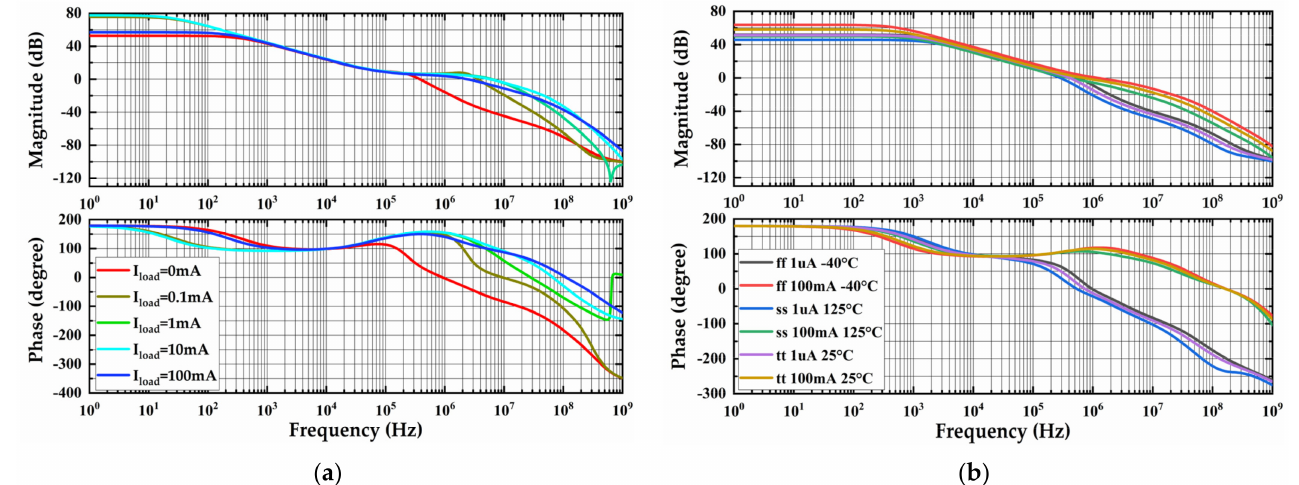
Figure 8. ( a ) Loop gain of the proposed OCL–LDO under different load conditions with C L = 100 pF; ( b ) Loop gain versus load current, temperature, and process corner.